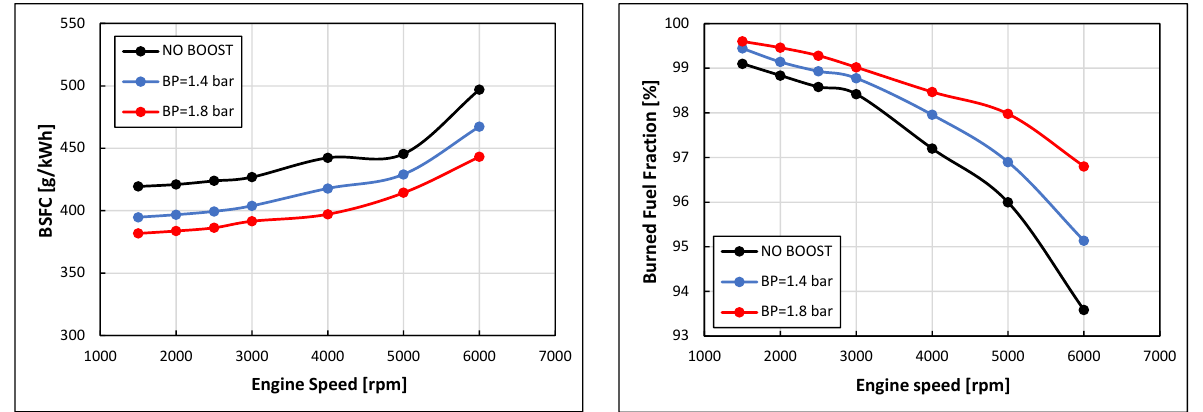
Figure 9. BSFC ( left ) and burned fuel fraction ( right ) for different boost levels. ϕ = 1. WOT.